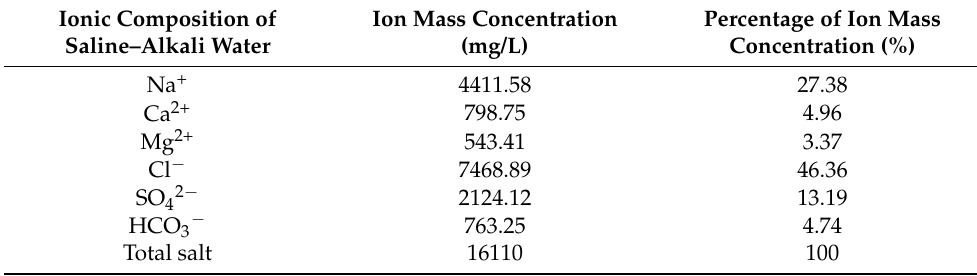
Figure 2. Physical drawing of the farmland saline–alkali water separation and desalination device: (1) shading canopy; (2) towerless water supply; (3) pretreatment filtration equipment; (4) inlet of the solar cycle collector; (5) flash drum inlet; (6) flash tank; (7) shell-and-tube circulating condenser; (8) negative pressure tank; (9) water ring vacuum pump; (10) freshwater tank; (11) salt-drying box; (12) control box; (13) solar cycle collector; (14) photovoltaic panel. Table 1. Composition of saline–alkali water after pretreatment.